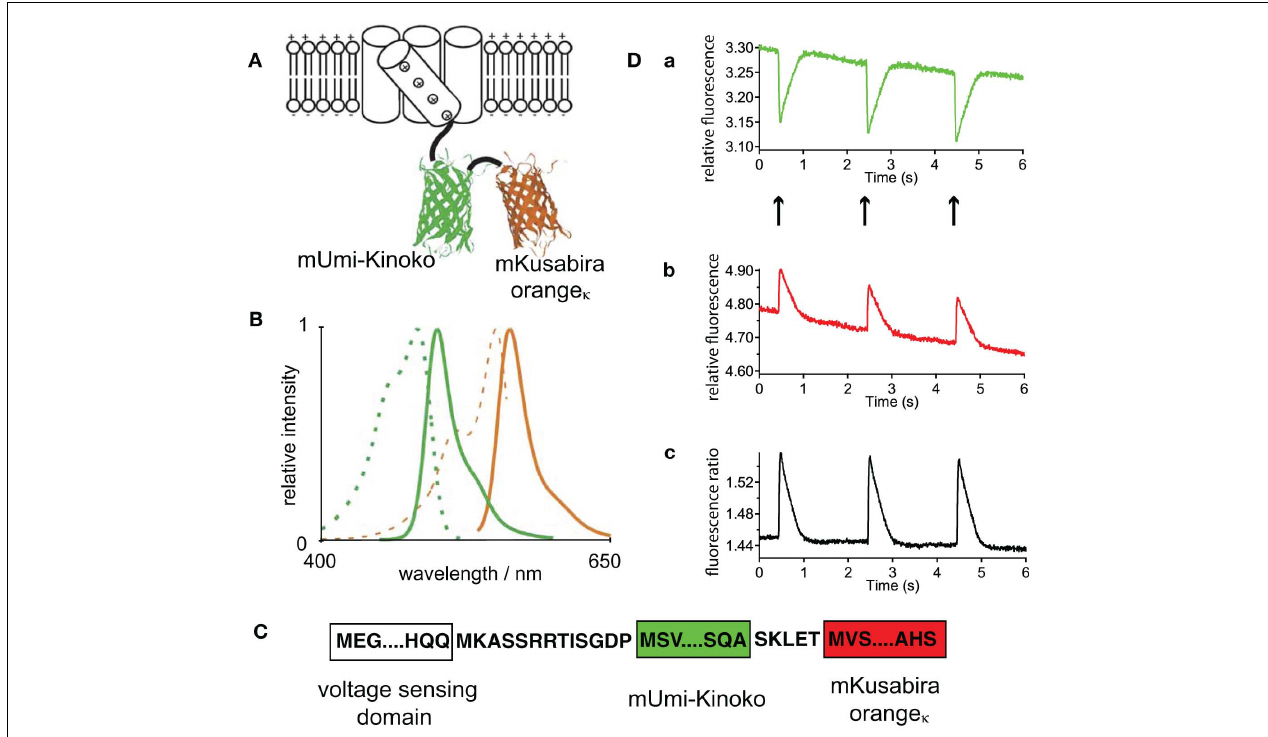
there have been conflicting reports concerning the linker sequences of Mermaid (Tsutsui et al., 2008; Mutoh et al., 2009), in (C) we provide the linker sequence of the construct used for our investigations [cp. (D) ]. (D) Depicts action potential recordings from viral transduced Mermaid in isolated ventricular myocytes. (a,b) Are traces of the fluorescence intensity of the two spectral channels, while (Dc) presents the ratio of (a,b) . (D) Is a reprint fromTian et al. (2011) with friendly permission of S. Karger AG (Basel,